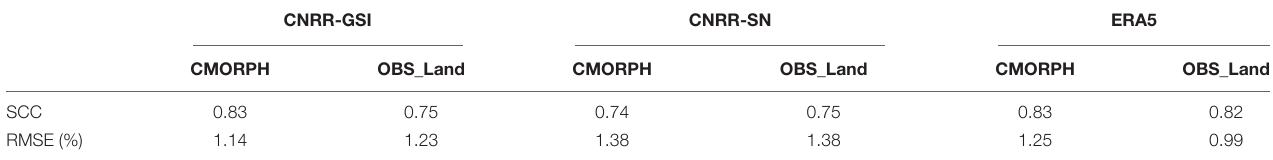
Figure 6 . Only daily precipitation above 0.1 mm/day is used to generate PDFs. Precipitation probability generally